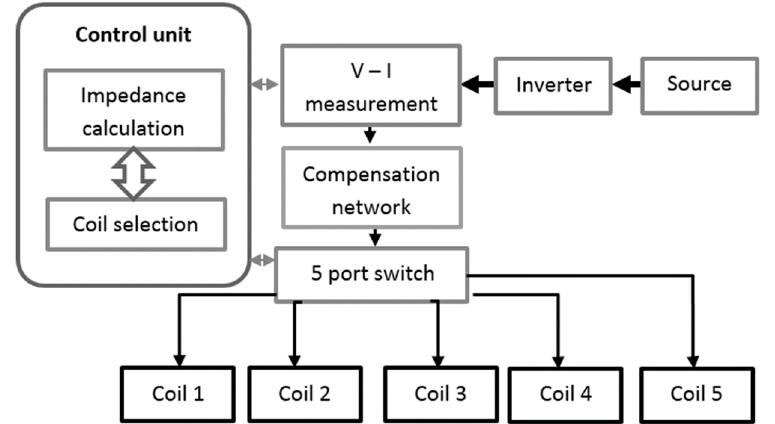
in vs. coupling factor k .